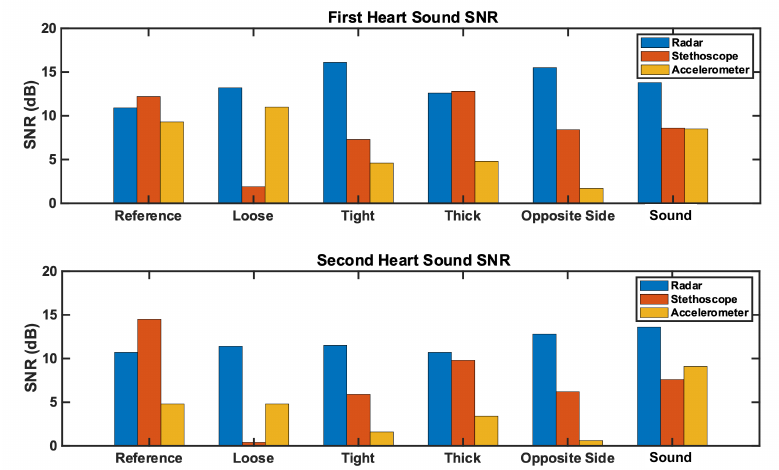
Figure 11. Comparison of the SNR for each measurement method across test cases. The ( top ) plot represents the first heart sound. The ( bottom ) plot represents the second heart sound. Radar SNR remains constantly high across test cases, while stethoscope and accelerometer SNRs vary significantly by test case.